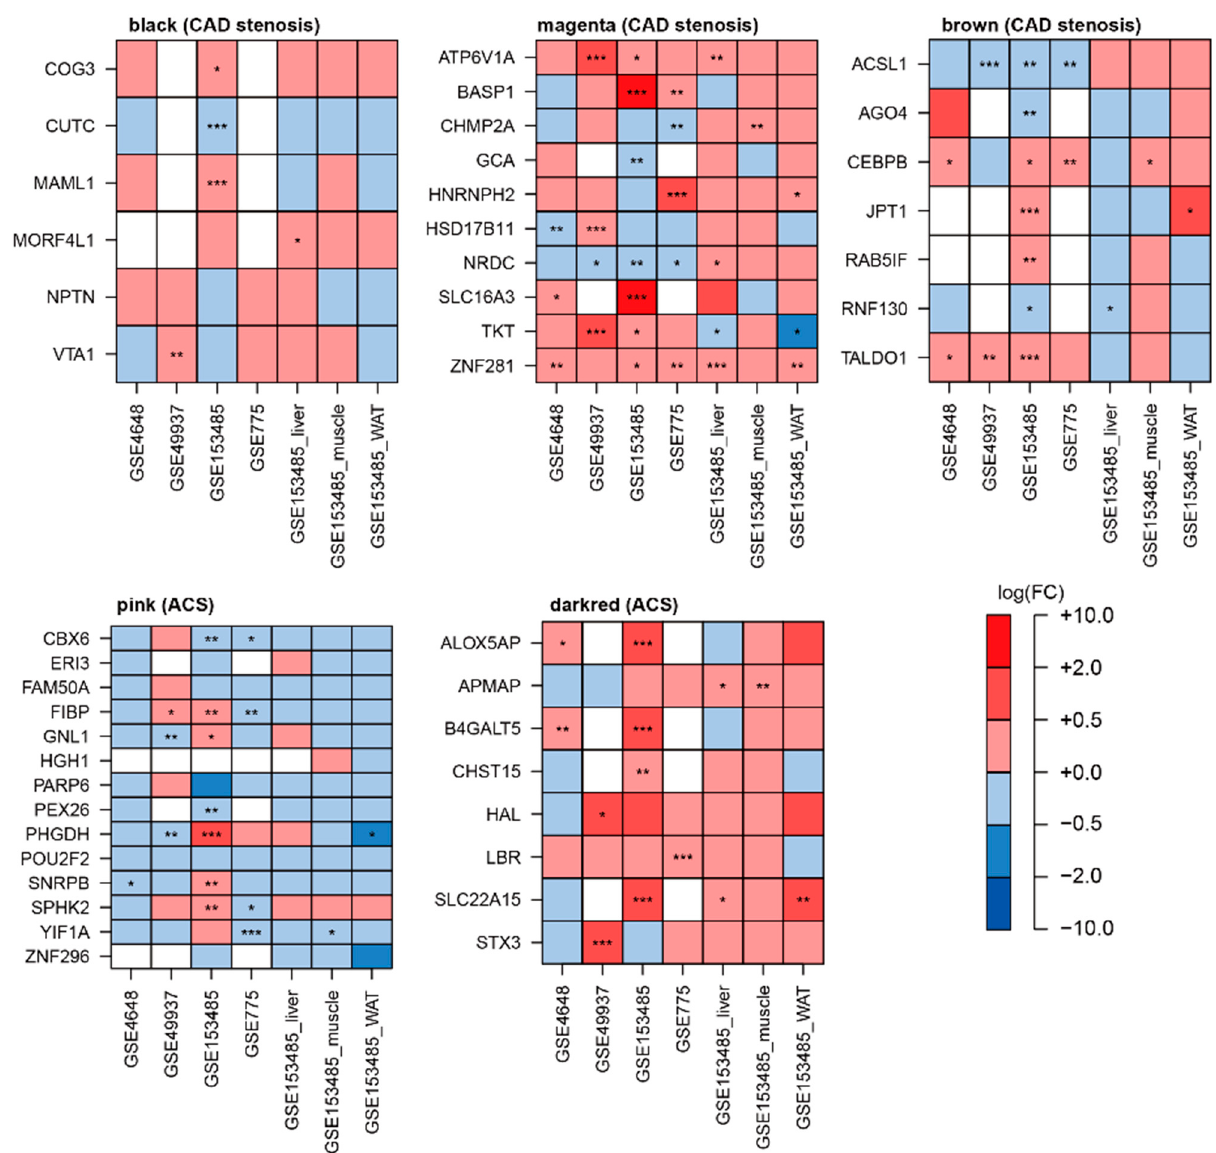
Figure 9. Replication analyses from independent mice CVD datasets for genes in five modules (black, magenta, brown, pink, and dark red). FC values (logFC) between two conditions were calculated using the limma package. The empty rectangles colored in white are gene expression levels that are not included in the animal data. ***, **, *, and # denote p.adj < 0.001, p.adj < 0.01, p.adj < 0.05, and p < 0.05, respectively. Black, magenta, and brown are obtained from CAD stenosis-related datasets and pink and darkred modules were made from ACS-related datasets. Abbreviations: CVD, cardiovascular disease; FC, fold change; p.adj , p -value adjusted by false discovery rate.